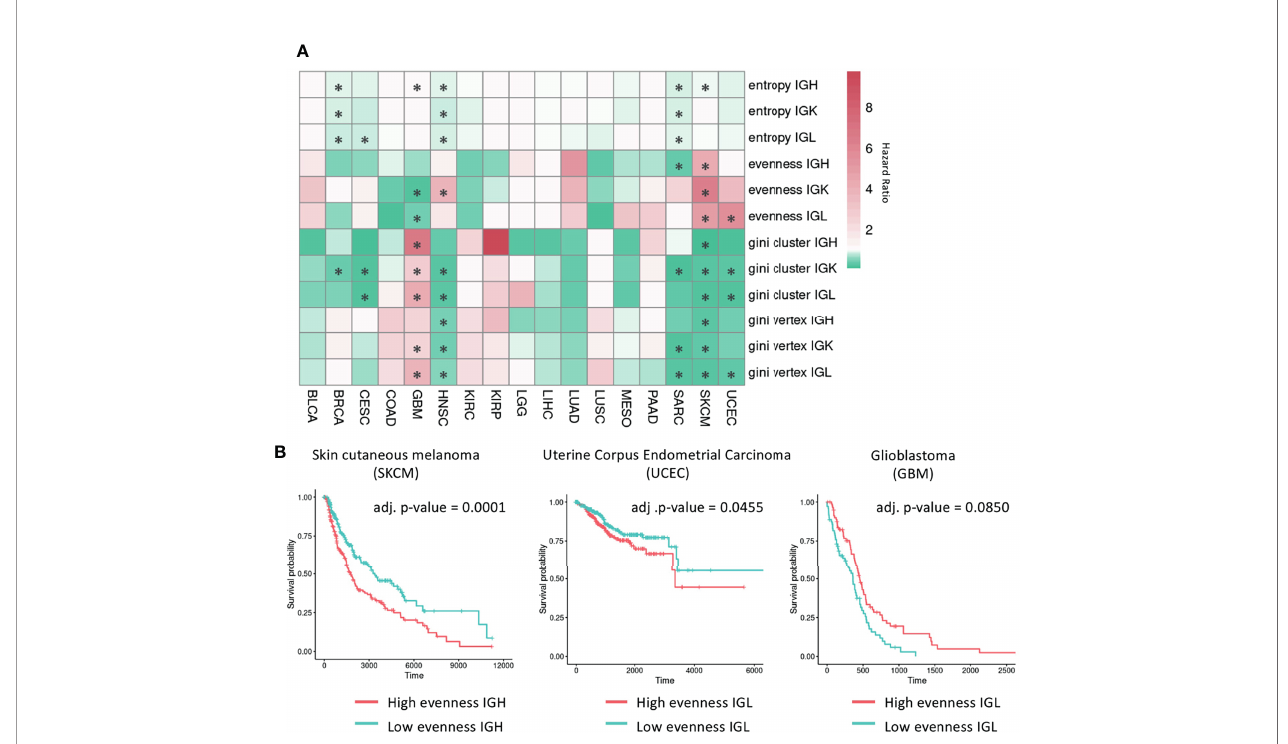
FIGURE 6 | Survival analysis using B cell repertoire features. (A) Heatmap showing the hazard ratio from a Cox proportional hazards model for each B cell repertoire feature adjusted for age, gender, and tumor stage. Red indicates a hazard ratio greater than 1 and green indicates a hazard ratio less than 1. Signi fi cant associations (FDR < 0.1) are marked by an asterisk. (B) Kaplan-Meier curves for samples with high and low evenness with the median evenness value used as the cutoff. The adjusted p-values are from the multivariate Cox regression models adjusted for age, gender, and tumor stage with the Benjamini-Hochberg procedure used to control for multiple